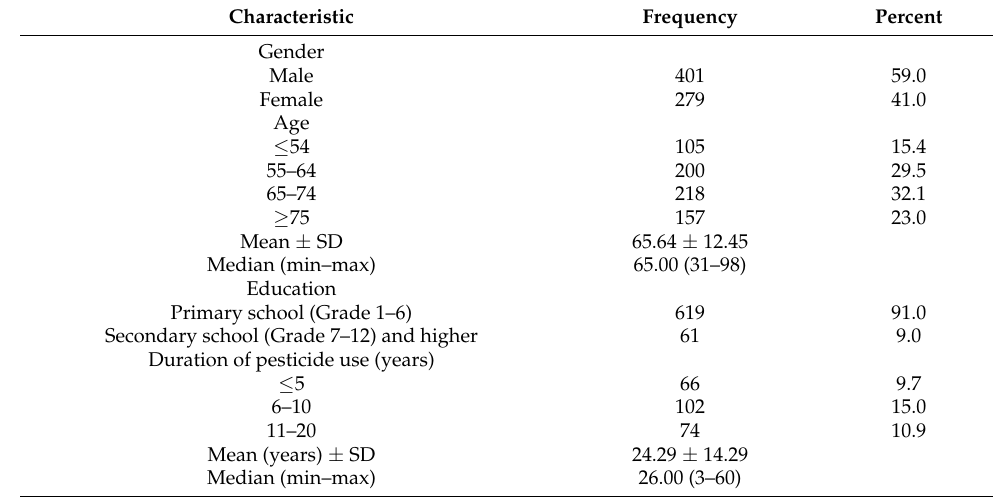
Table 1. Demographic data of participating farmers in Nakhon Sawan (N =